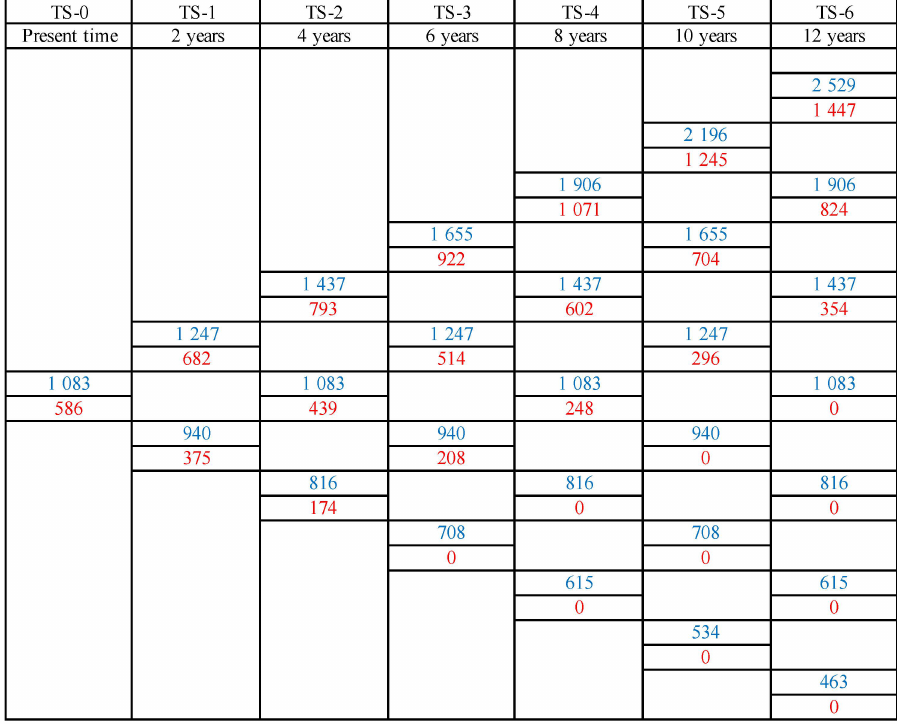
Figure 11. Binomial lattice model for the highest future value node of SC–1 expansion configuration (Million